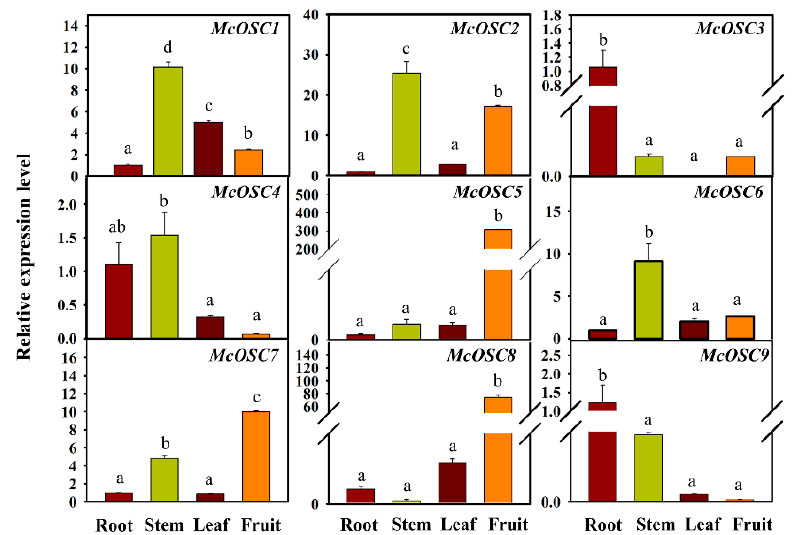
Figure 2. Relative transcript levels of McOSC s in different tissues (root, stem, leaf, and fruit) of bitter gourd, as determined by qRT ‐ PCR analyses. Data are means ± SD from three independent experiments. a, b, c, and d indicate significant difference at p < 0.05 (independent samples t ‐ test). Statistical analysis was performed using IBM SPSS Statistics 20.0.